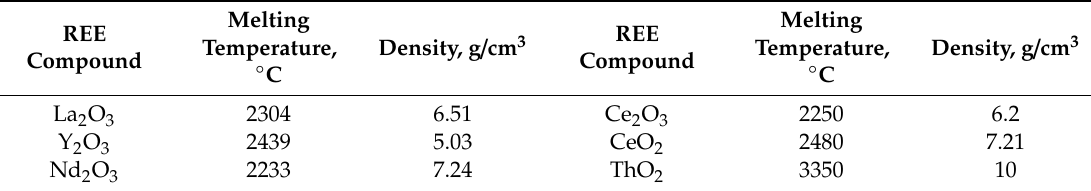
Table 2. Physical properties of refractory oxides of REEs [32–35].